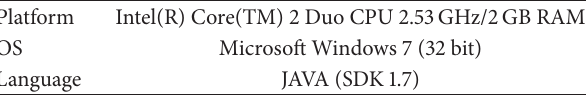
Table 2: Implementation environment.